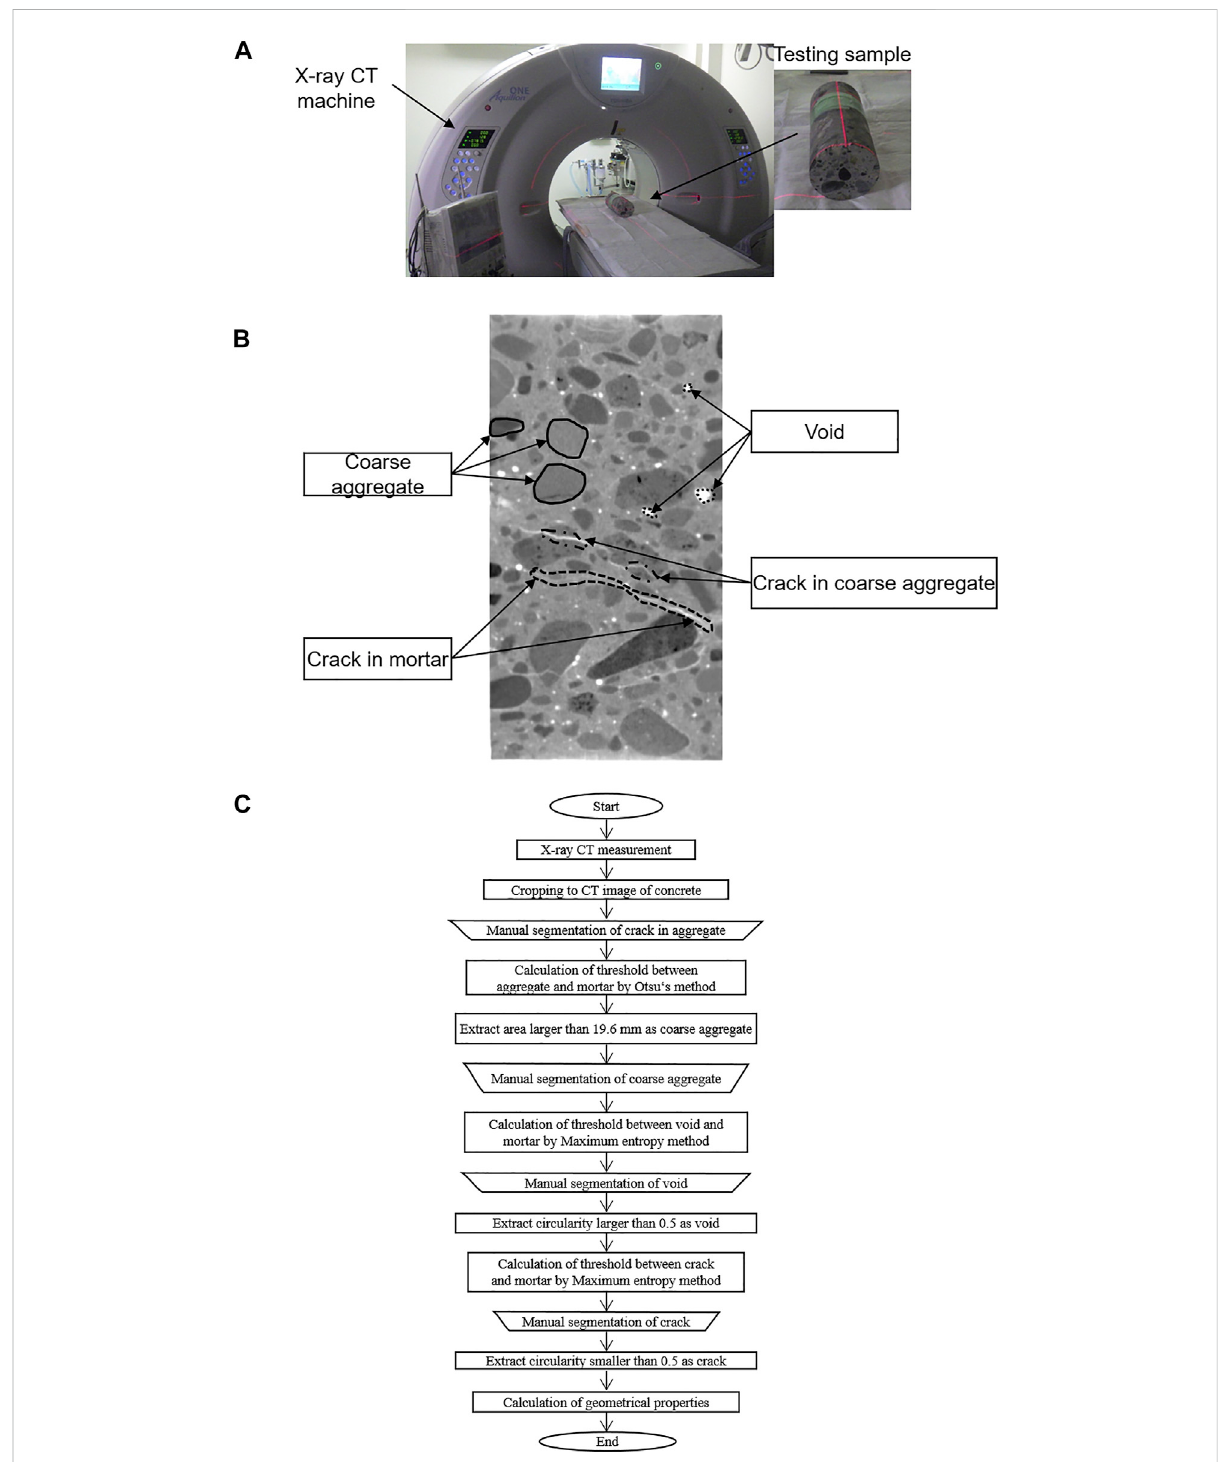
FIGURE 2 X-ray CT technique. (A) A general view of the CT machine. (B) X-ray CT characteristics. (C) The fl ow of X-ray CT image